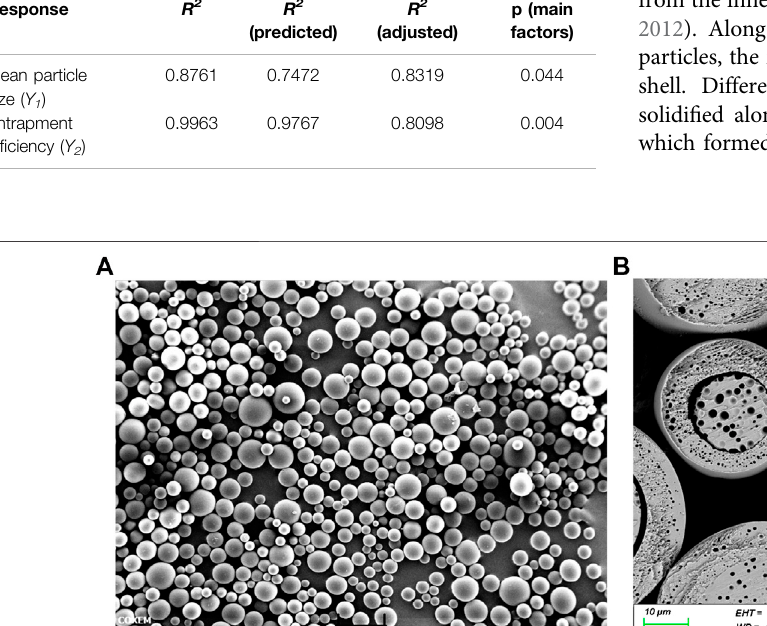
Frontiers in Pharmacology |